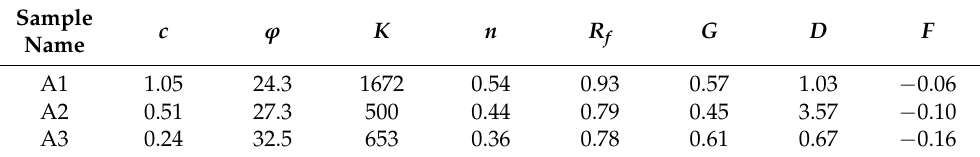
Table 2. Duncan Zhang E-v model